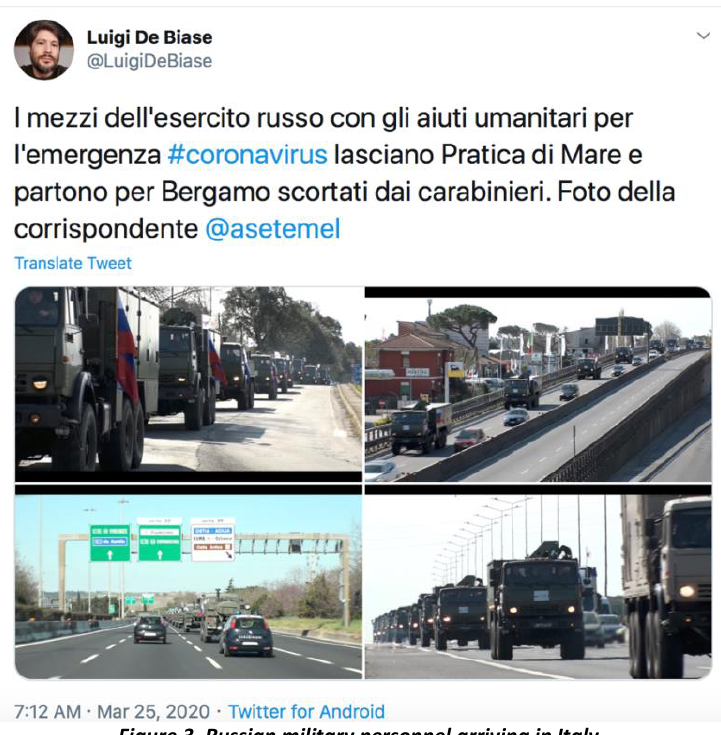
Figure 3. Russian military personnel arriving in